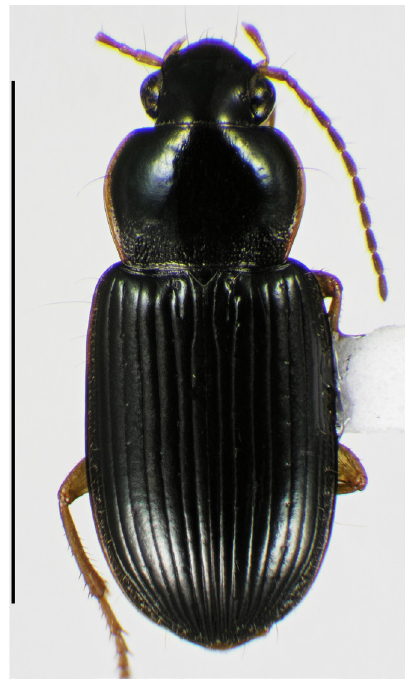
Figure 26. Habitus digital image of Selenophorus hylacis species group, in part, dorsal aspect, S. subquadratus (Putzeys). Scale bar 5